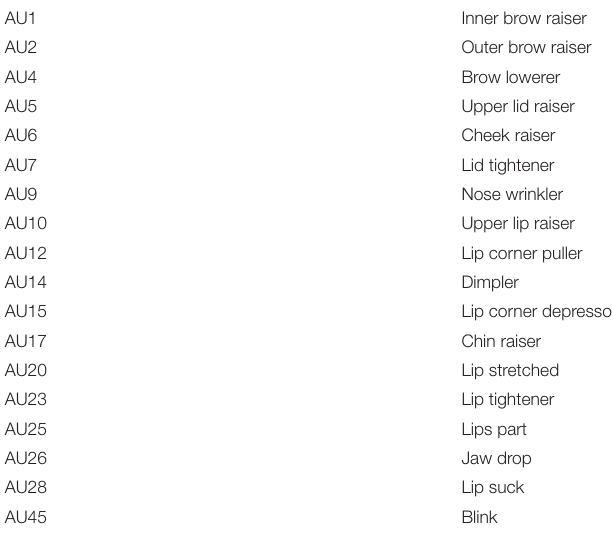
TABLE 1 | Action unit code for specific face muscle activity.